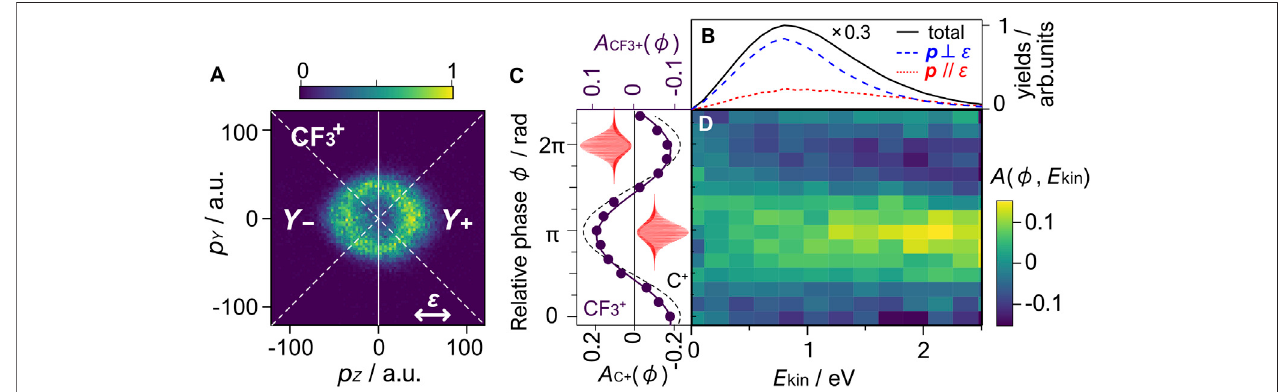
FIGURE5|(A) MomentumimageofCF + 3 fragmentionsproducedin ω -2 ω intenselaser fi elds(50fs,1.4×10 14 W/cm 2 ,800and400 nm),averagedovertherelative phase (0 ≤ ϕ ≤ 2 π ). The image is a slice of the three-dimensional ion momentum distribution in the Y - Z plane with a thickness of | p X | < 10 a.u. The arrow represents the direction of the laser polarization. (B) Total kinetic energy release spectra of CF + 4 → CF + 3 + F (solid) plotted together with the parallel (dotted) and perpendicular (dashed) components, de fi ned by the polar angles of 0 ° ≤ θ ≤ 20 ° and 75 ° ≤ θ ≤ 90 ° , respectively. The total spectrum is multiplied by 0.3. (C) The asymmetry parameter ( ϕ ) for the CF + fi tting (solid line) (see text). The fi tting results for the C + A CF + 3 fragment ions with an acceptance angle of 45 ° (solid circle) and the results of the least-square 3 ion produced bythe Coulomb explosion ofCO(4 eV ≤ E kin ≤ 8 eV)arealso plotted(dashed line). Thelaser pulseshapes at ϕ = 0and π areshown. (D) Two-dimensional plot of the asymmetry parameter A ( ϕ , E kin ) for CF + 3